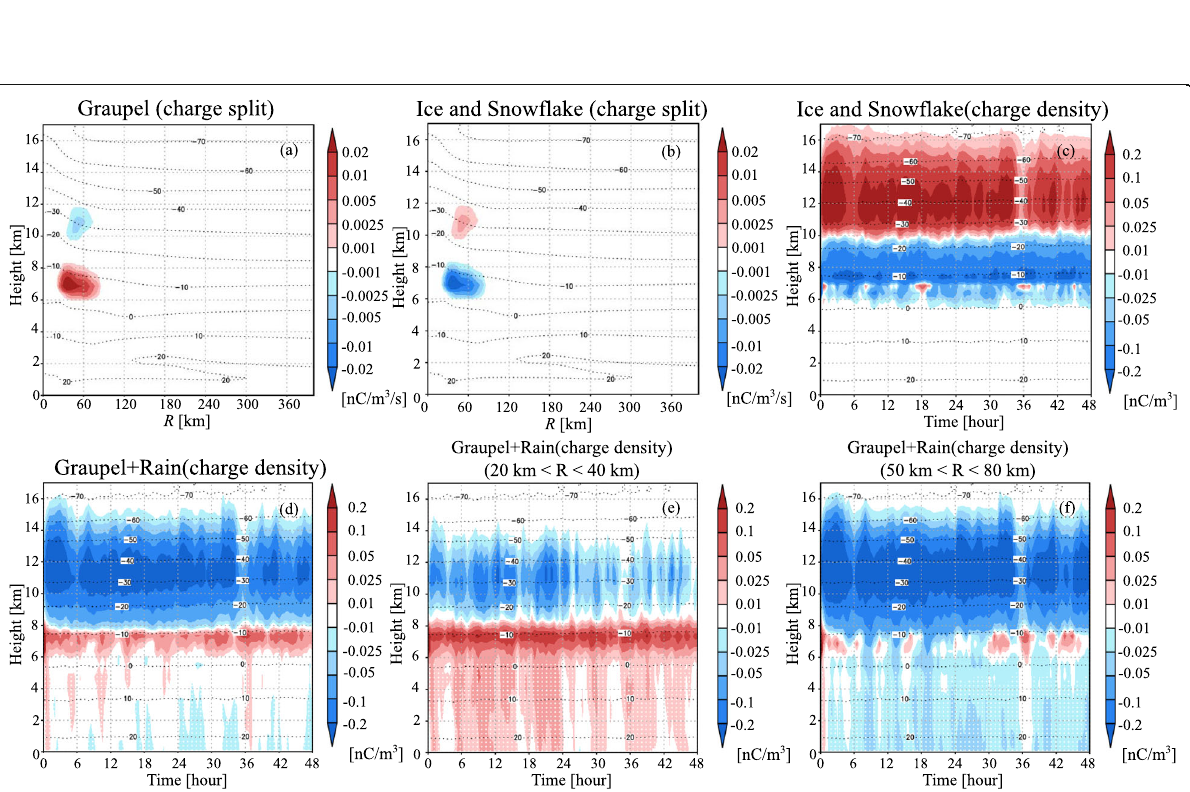
Fig. 5 a , b Charge density rate added to a graupel and b ice and snow by non-inductive charge separation over the z – R plane, tangentially averaged during the last 12 h of the simulation. c , d Temporal evolution of charge density of c ice and snow and d graupel and rain tangentially averaged over 20 km < R < 80 km, and e , f temporal evolution of charge density of graupel and rain tangentially averaged over e 20 km < R < 40 km and f 50 km < R < 80 km. The white dotted area in d – f indicated the charge density of raindrops. The dotted line indicates temperature